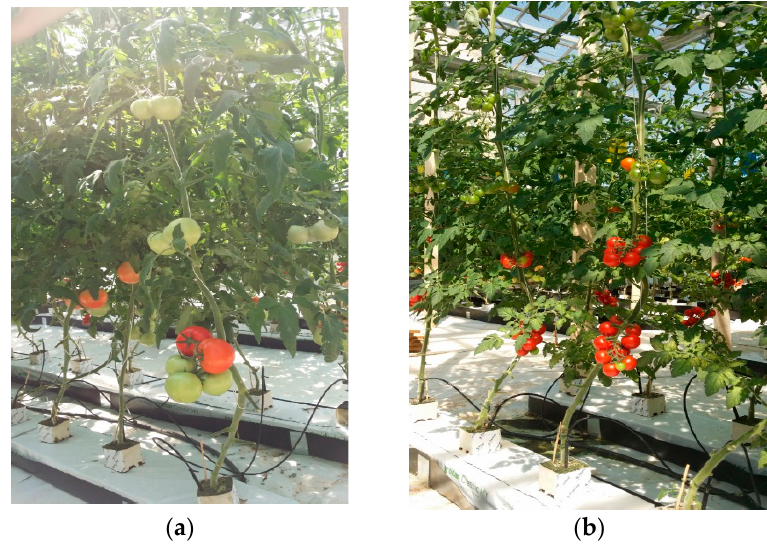
Figure 1. Table tomato hybrids selected for cultivation: ( a ) Hybrid “Oasis” (medium-sized tomato, MST); ( b ) hybrid “Genio” ( cherry tomato, ChT).